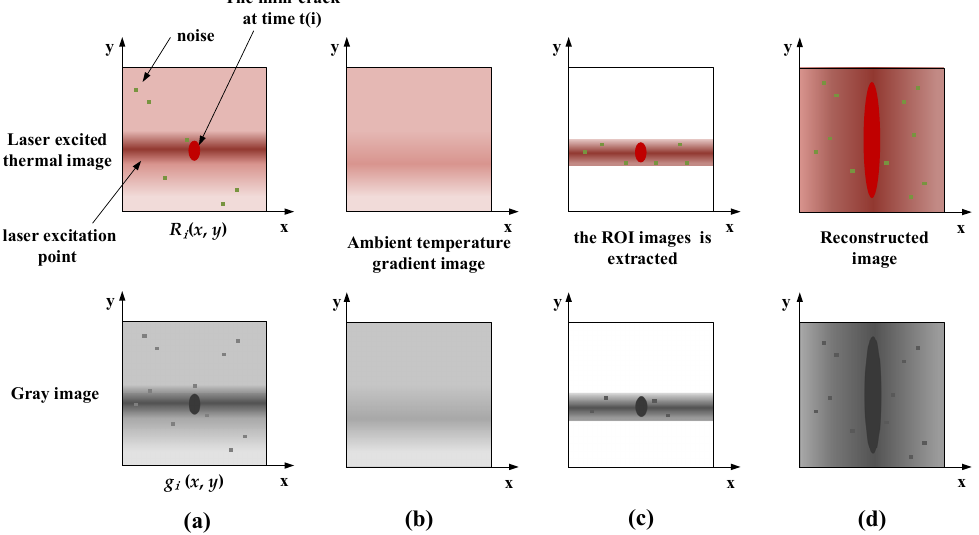
Figure 4. Process of image reconstruction. ( a ) Thermal response image R i ( x , y ) and its gray image; ( b ) reference image Res ( x , y ) and its gray image; ( c ) grayscale feature images F i * ( x, y ) and its gray image; ( d ) mini-crack feature image M ( x , y ) and its gray image.